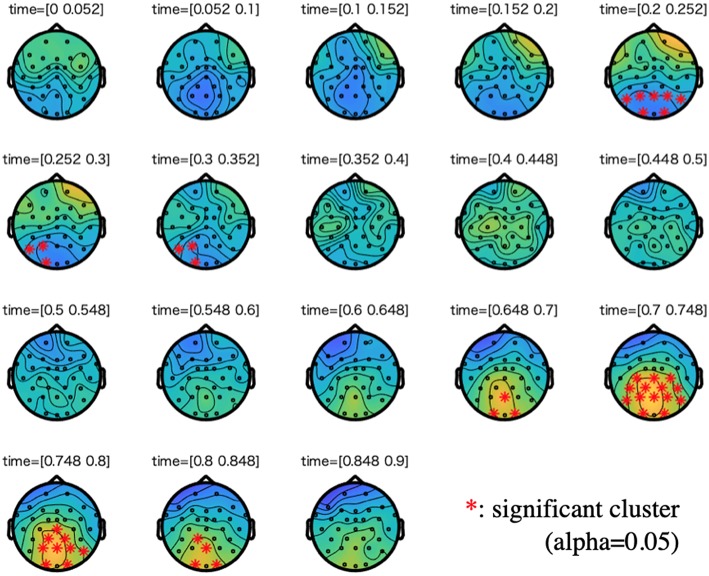
Cluster-based permutation tests on the ERPs of the syntactic condition along with a difference wave between incorrect and correct conditions. We plotted 0 to 900 ms to the stimuli onset. For each time step of interest (time range: 0.05), we highlighted the electrodes that are members of significant clusters (cluster alpha value: 0.05). A cluster is significant if its p-value is less than the critical alpha level.